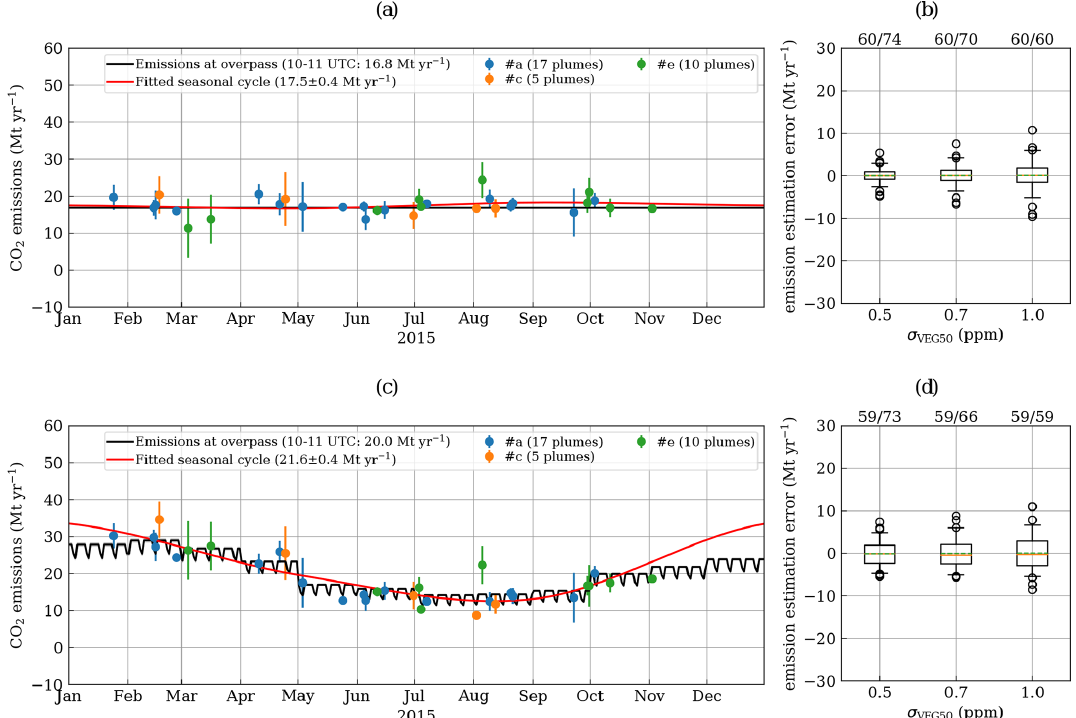
Figure 2. Time series of CO 2 emissions of Berlin estimated with the analytical inversion using three satellites (#a, #c and #e) with σ VEG50 of 0.7ppm for (a) constant and (c) time-varying emissions. Emission estimates with uncertainties larger than 10.0Mtyr − 1 (50% of mean emissions at 11:30LT) were removed. (b, d) Boxplots of the difference between estimated and true CO 2 emissions of Berlin using six satellites for the three different instrument noise scenarios. The boxes denote the range between 25th and 75th percentiles, orange lines are median values, dashed lines are mean values, and whiskers are 5th and 95th percentiles. The numbers above the boxes are the cases where the uncertainties for all three scenarios are less than 50% (first number) and the number of successful emission estimates for each scenario (second number). Table 2. Performance of the analytical inversion for individual satellite overpasses in terms of mean bias (MB) and standard deviation (SD) of the difference between estimated and true CO 2 emissions of Berlin. More plumes could have been used for emission quantification for scenarios with low noise (second value in column “Number of plumes”), but the statistics were computed only for those plumes that could be used with the high-noise scenario (first value) for better comparability of the results. Emissions σ VEG50 Number of plumes Mean bias (MB) Standard deviation (SD) (ppm) Mtyr − 1 % Mtyr − 1 Time constant